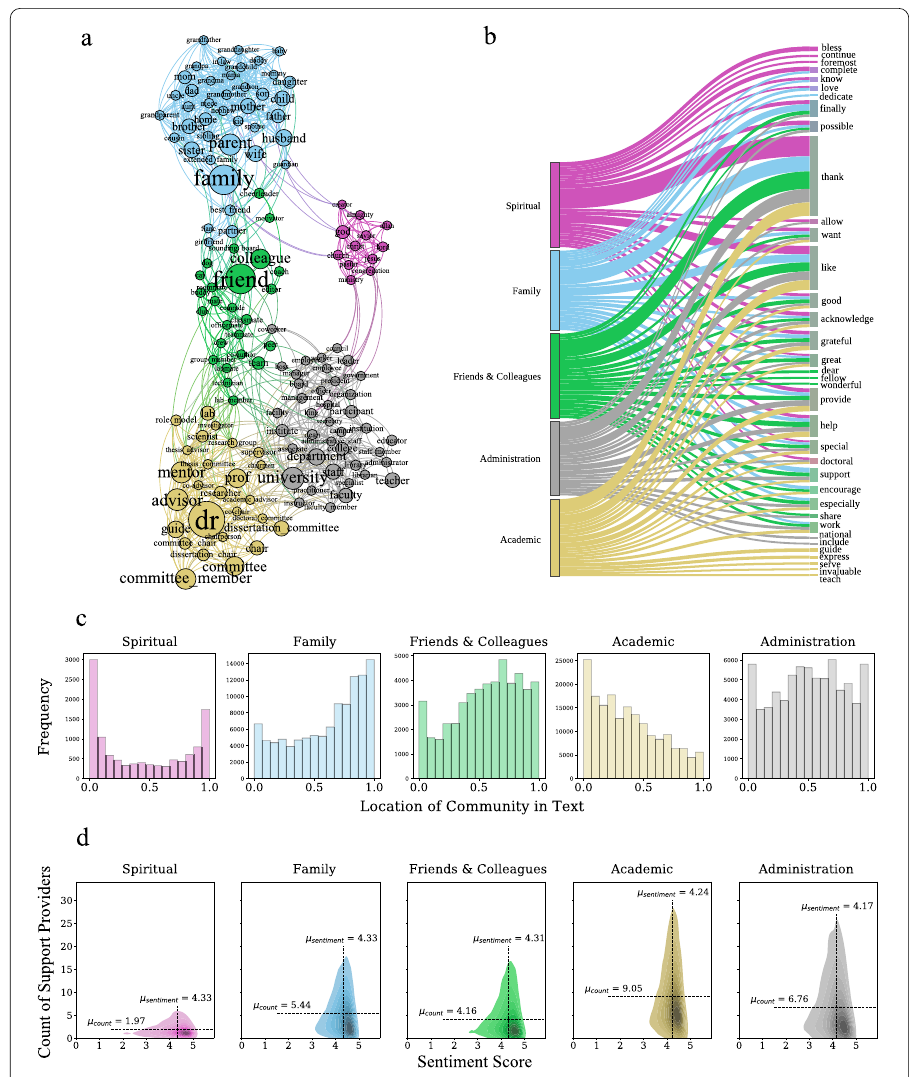
Figure 1 Analyzing support providers in acknowledgements. Different support providing entities identified in dissertation documents represented as nodes and their contextual similarities learned from document embeddings used as edge weights ( a ). Community detection revealed 5 distinct groups: Family, Friends & Colleagues, Academic, Administration and Spiritual. These groups are acknowledged using specific words and bi-partite relation points group specific properties ( b ). Location of mention in the acknowledgement text indicates norms among scholars to highlight distinct groups ( c ). Support providers are also differ in terms